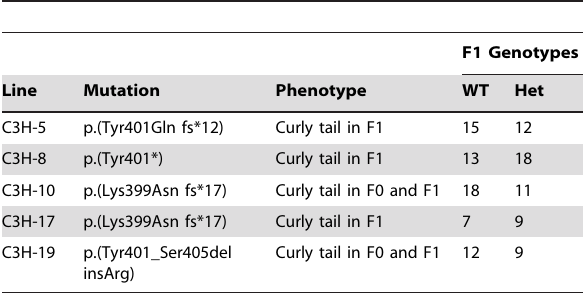
Table 2. Mutant Zic2 Founder line